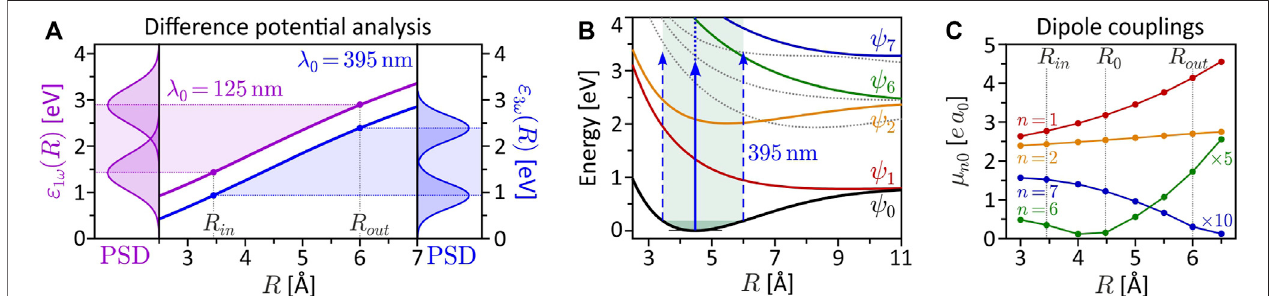
FIGURE 6 | (Color online.) Derived quantities to characterize the interdependence of electronic and nuclear dynamics. (A) Difference potential analysis for the SPI scheme (magenta curve) and the MPI scheme (blue curve). The left frame depicts the power spectral density (PSD) of the 125 nm, 2 fs pulse mapped at the inner and outer turning point of the vibration. The right frame shows the PSD of the third order spectrum of the 395 nm, 5 fs pulse. (B) Excitation scheme of the vibrating molecule interacting with the 395 nm pulse employed in the MPI scheme. At the outer turning point, state ψ 6 is excited resonantly from the ground state. (C) R